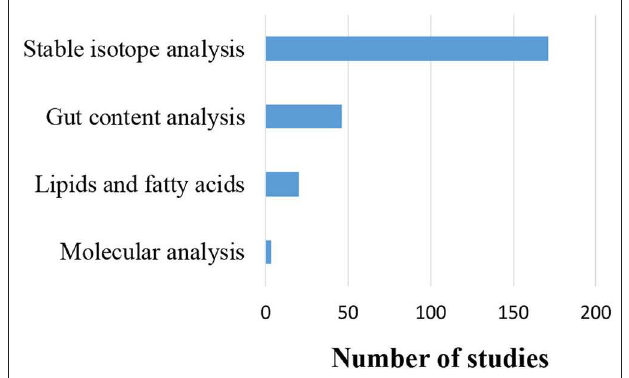
FIGURE 7 | Number of studies that used each trophic relationship determination technique, alone or in combination with others ( N = 206).